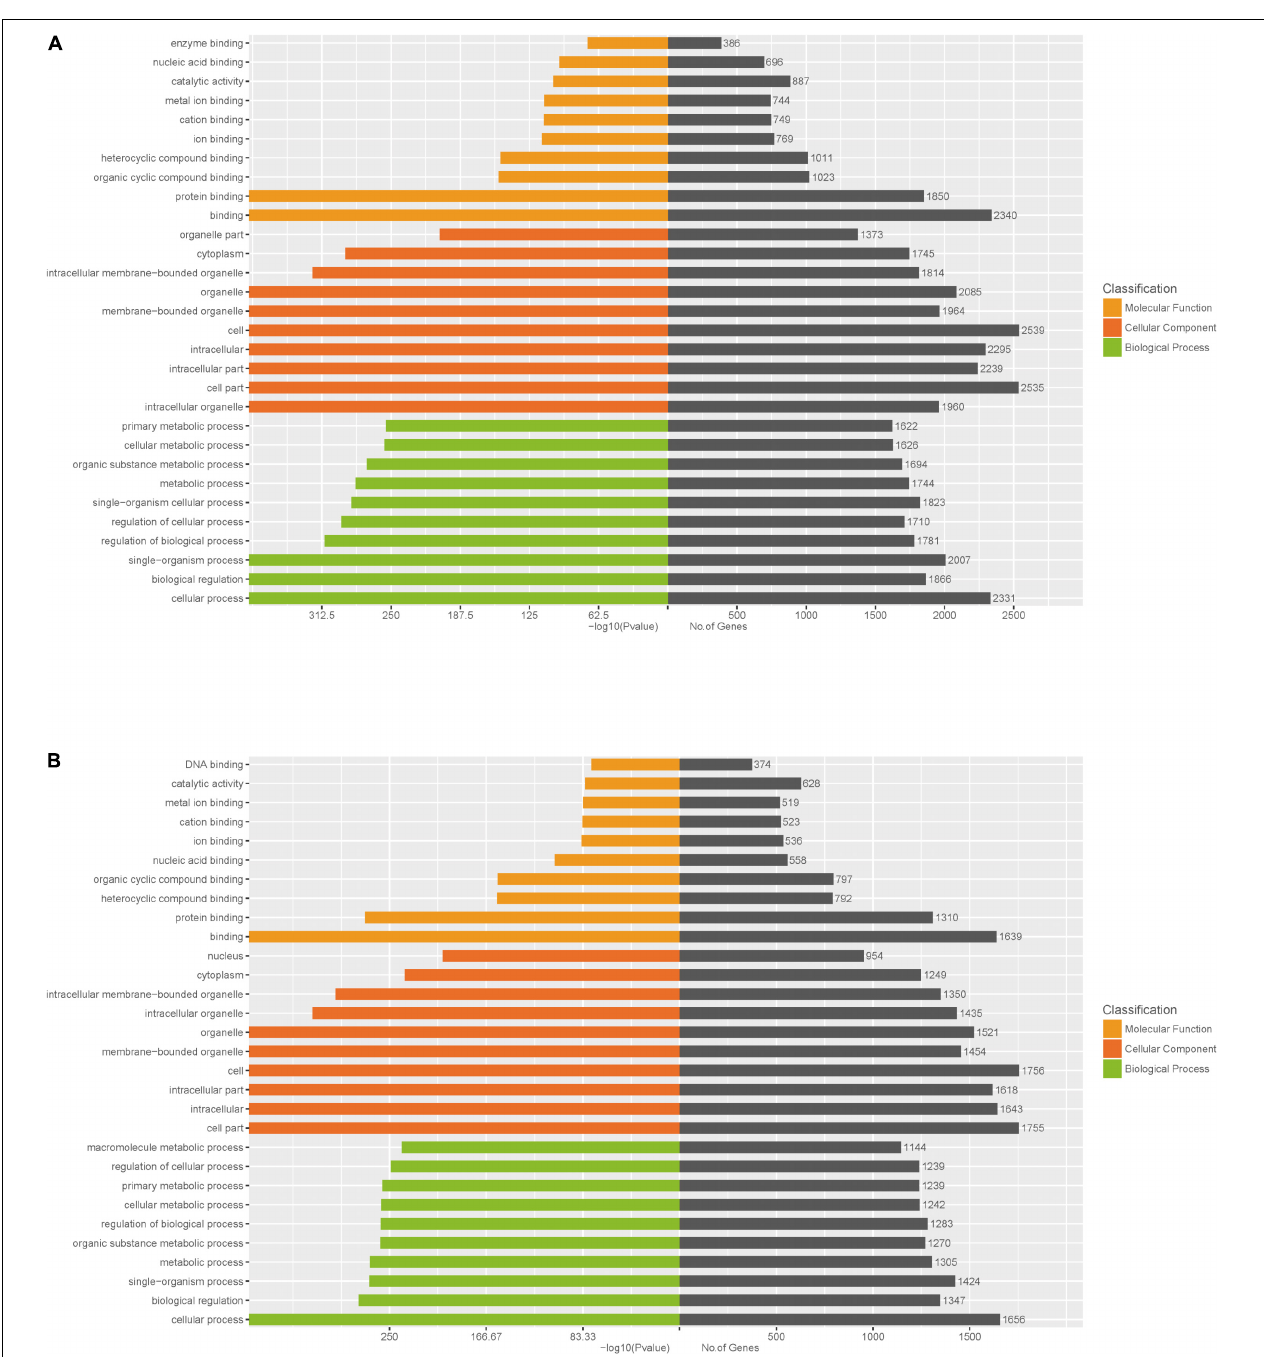
FIGURE 6 | GO enrichment analysis for target genes of miRNAs with differently levels. The GO enrichment histograms and GO terms for target genes of up-regulated miRNAs (A) and down-regulated miRNAs (B) are